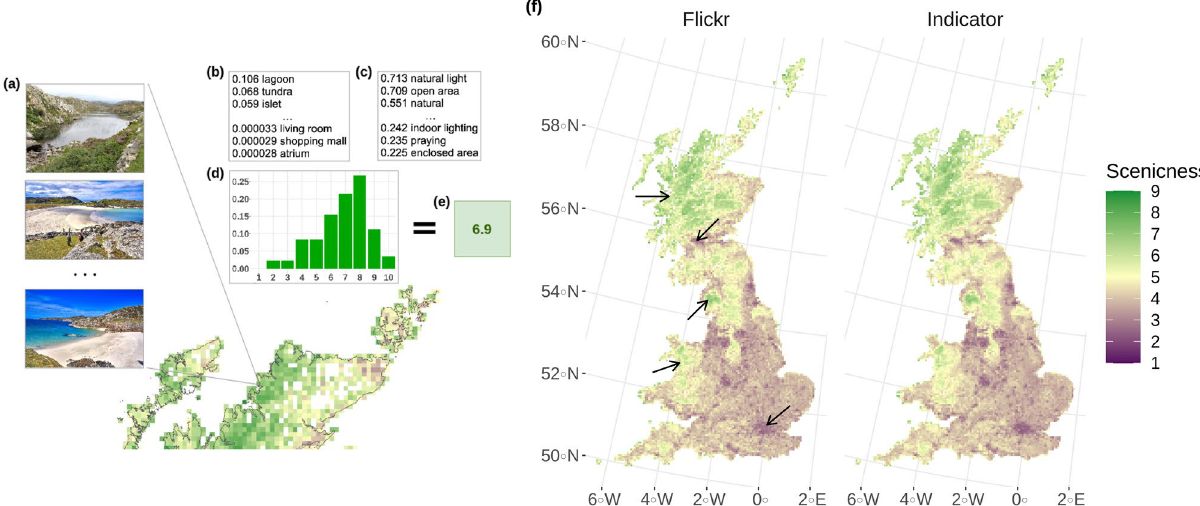
Figure 1. A Flickr and deep learning-based prediction of scenicness at 5 km resolution for a single cell covering Achmelvich Bay, Scotland, and for Great Britain, in comparison to the indicator model. The deep learning-based models used ( a ) Flickr images to generate ( b ) 365 scene class scores and ( c ) 102 SUN attribute scores, as well as ( d ), a normalised scenic rating distribution. These were then used to build a random forest model to generate ( e ) a scenicness prediction. In ( f ), predictions of the best-performing Flickr model for Great Britain are shown alongside the indicator model. From top to bottom, the arrows point to the Scottish Highlands, Glasgow, the Lake District, Snowdonia National Park and London. Drawn using R 3.6.3. (https:// www.r- proje ct. org/) with the ggplot2 3.3.5 (https:// ggplo t2. tidyv erse. org) and cowplot 1.1.0 (https:// cran.r- proje ct. org/ packa ge= cowpl ot packages). Photos © Sergio and © Graem e Churc hard (cc- by/2.0).